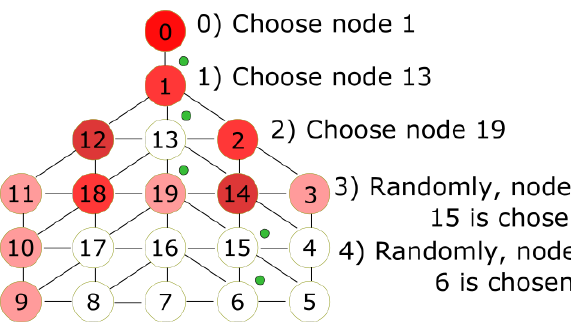
Figure 5. Reconnaissance example using the heuristics. The number of stamps in a node is represented by the intensity of the color.